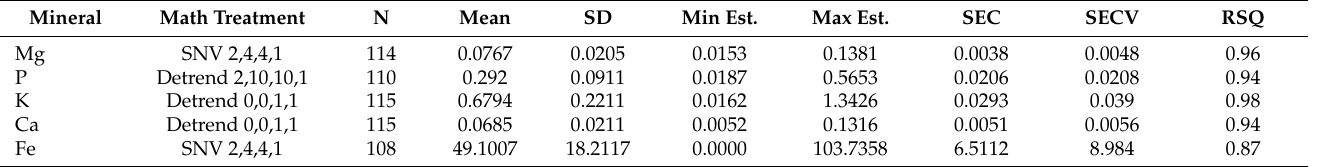
Table 4. Statistical descriptors for the best calibration equations obtained from NIR spectra and mineral composition data obtained by ICP-MS on flour